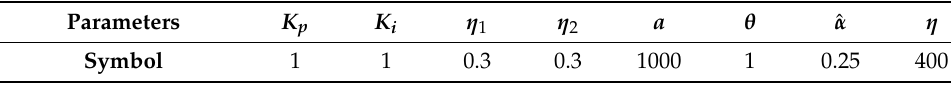
Table 3. The key parameters of the MFNLSMC